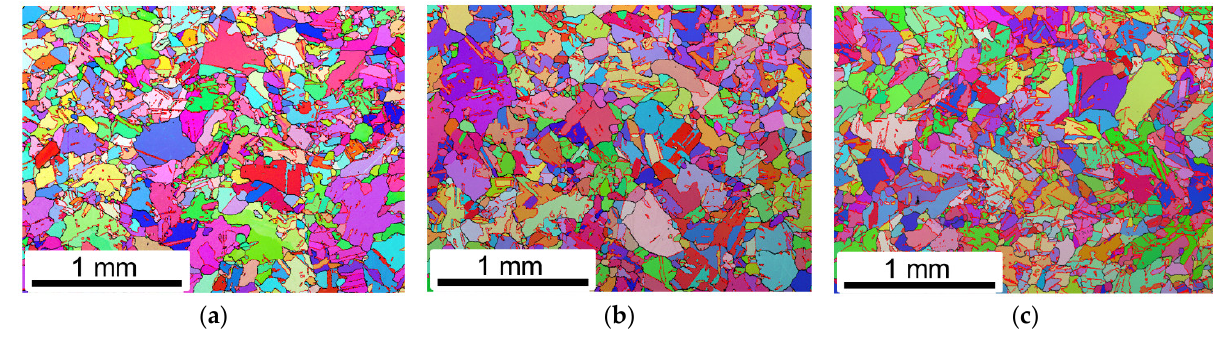
Figure 1. IPF maps: ( a ) HA-1080 °C, ( b ) HA-1180 °C and ( c ) HIP-DA.